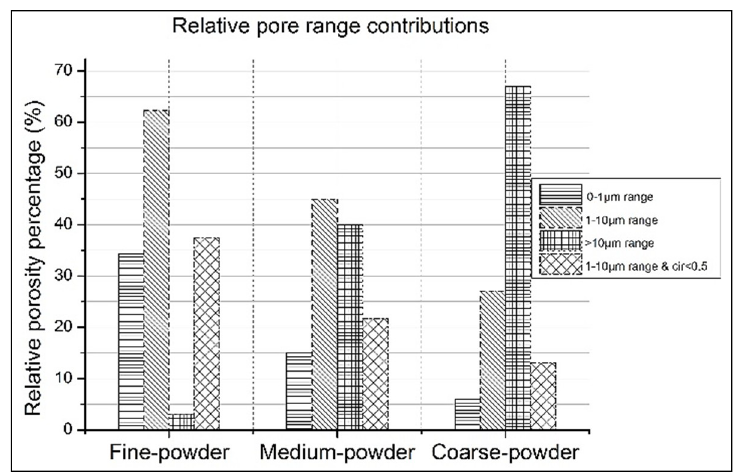
Figure 5. Relative pore range contributions out of total porosity.